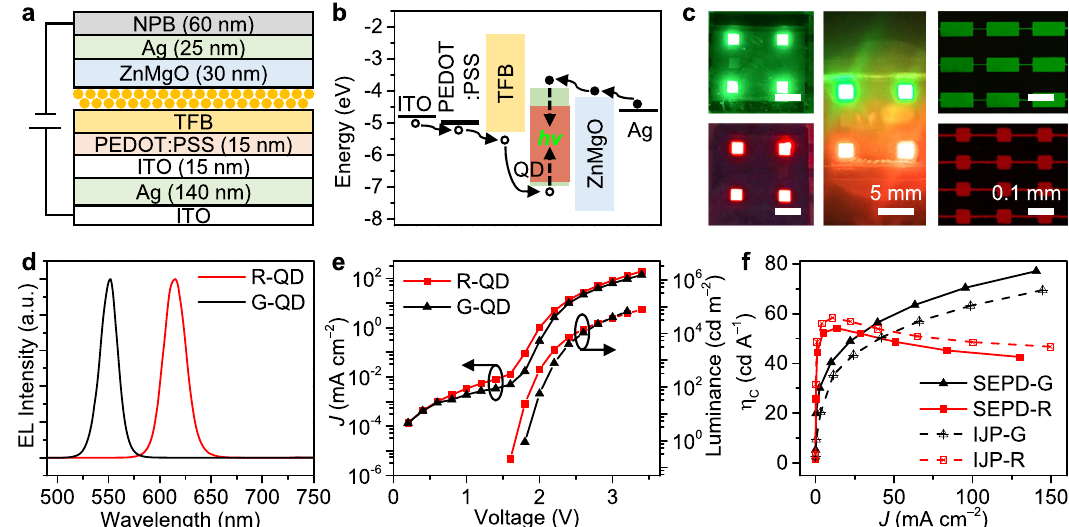
Fig. 4 Optoelectronic properties of SEPD-QLEDs. a Schematic illustration of the device structure of SEPD processed QLEDs. b Energy band diagram of the QLEDs. c Images and microscopy images of SEPD G-, R-, GR-QLEDs, G-QLED pixels, and R-QLED pixels. Scale bars, 5 and 0.1 mm, respectively. d Normalized EL spectra of green and red SEPD QLEDs. e Current density − luminance − voltage ( J − L − V ) characteristics of the green and red SEPD QLEDs. f Current ef fi ciency ( η C ) as a function of current density for the SEPD QLED and current density − voltage and luminance − voltage characteristics of SEPD green and red QLED. The maximum brightness of over 67,111 cd m − 2 at 3.2 V and 79,489 cd m − 2 at 3.4 V were achieved for green and red QLEDs, respectively. In addition, the green and red QLEDs exhibit peak current ef fi ciency ( η C ) of 77.0 cd A − 1 and 54.2 cd A − 1 , respectively, which are on par with the properties of the QLED prepared by IJP (Fig. 4f). An − 1 η η C histogram for 48 devices shows an average C of 69.1 cd A and 47.6 cd A − 1 for green and red QLEDs, respectively